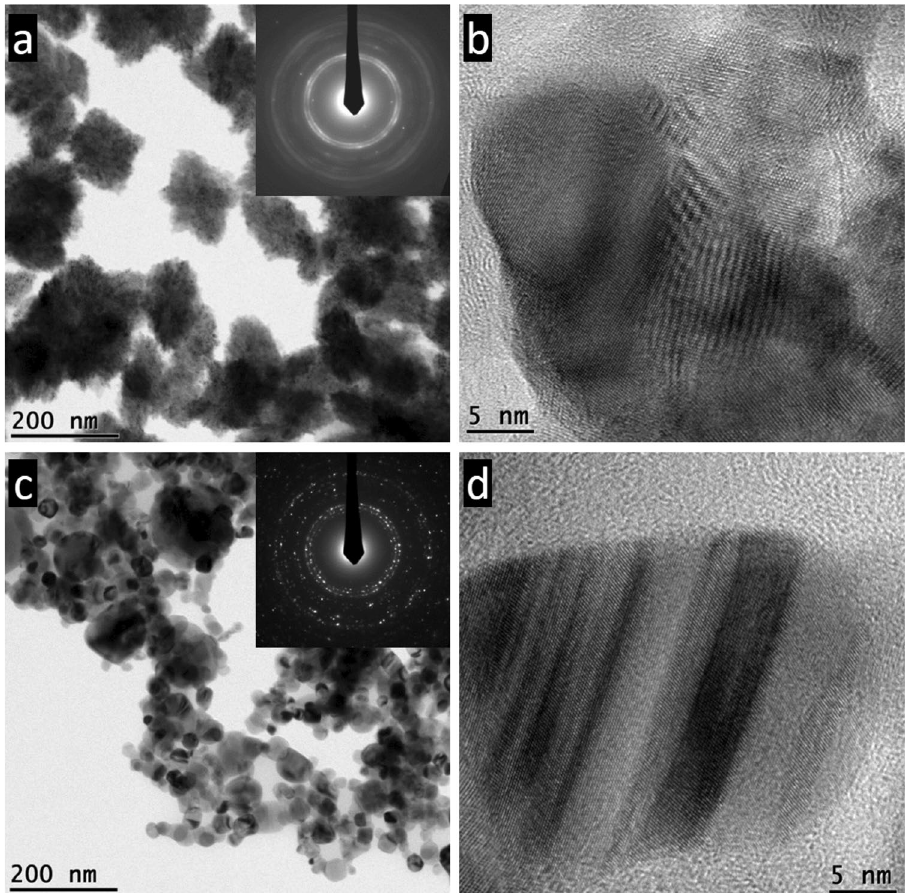
Figure 1. TEM images of CuO NPs. ( a ) Bright field image of sCuO NPs and related diffraction pattern (inset); ( b ) High resolution image of NPs as those reported in ( a ); ( c ) Bright field image of cCuO NPs and related diffraction pattern (inset); ( d ) High resolution image of a small nanoparticle of cCuO showing twinning